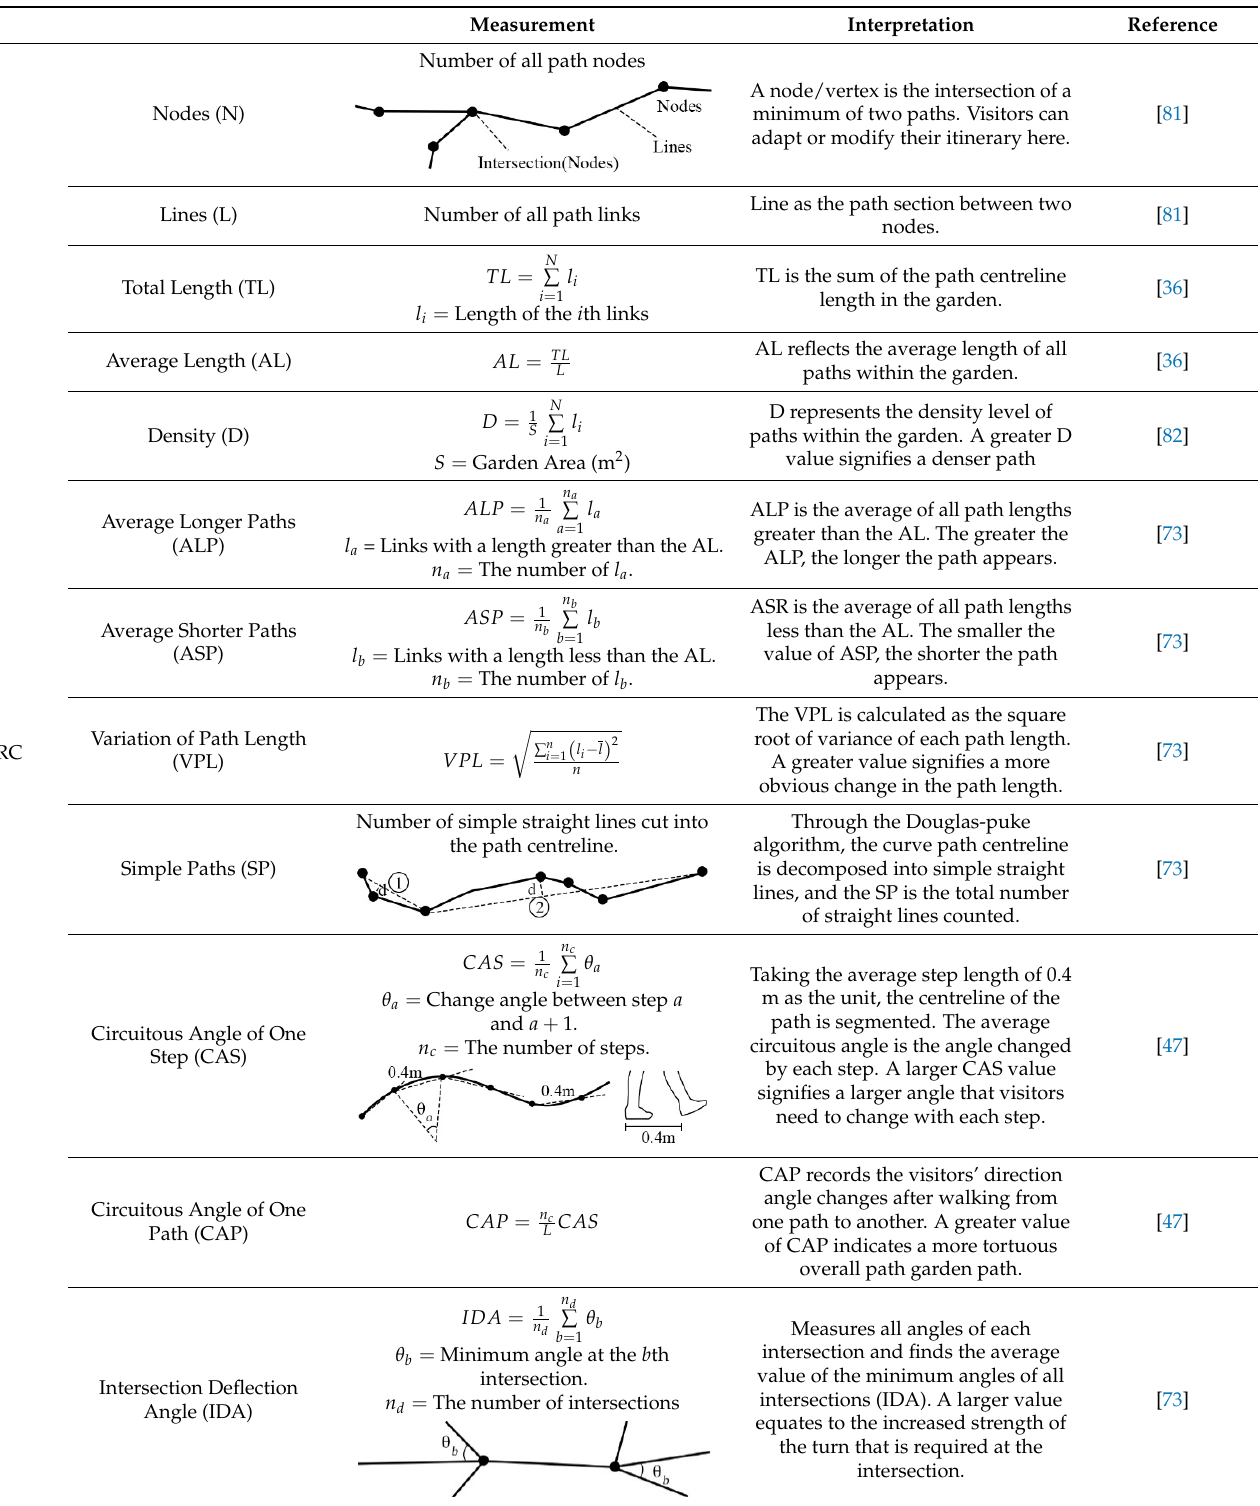
Table 1. Description of path quantitative indicators.